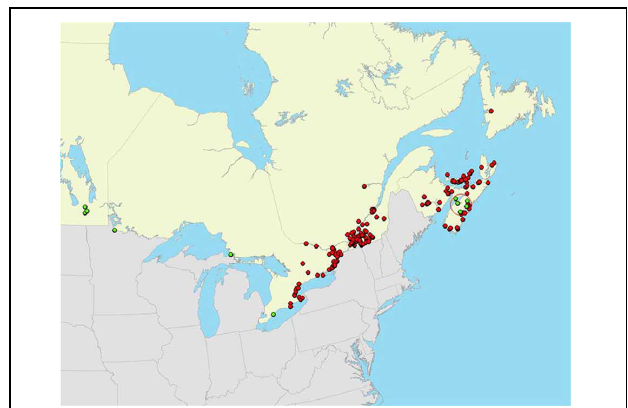
FIGURE 3 | Geographic distribution of B. burgdorferi -infected Ixodes scapularis ticks collected in passive surveillance in Canada in which the ospC major groups were identified in Ogden et al. (2011). A significant spatial cluster of ticks infected with B. burgdorferi carrying ospC major group I is indicated by the red circle. Reproduced with permission from Ogden et al.